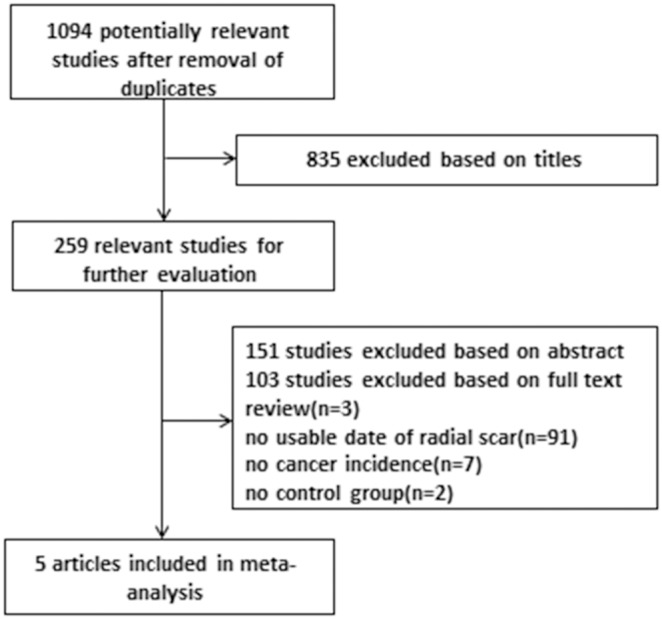
Flow chart of the selection of studies included in the meta-analysis.